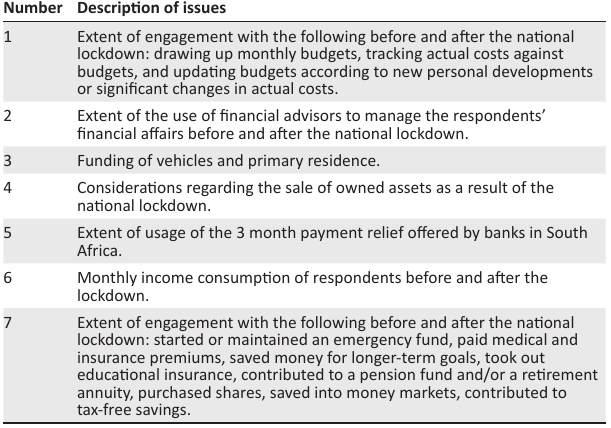
TABLE 1: Issues covered in the survey for the assessment of financial behaviour. Number Description of issues